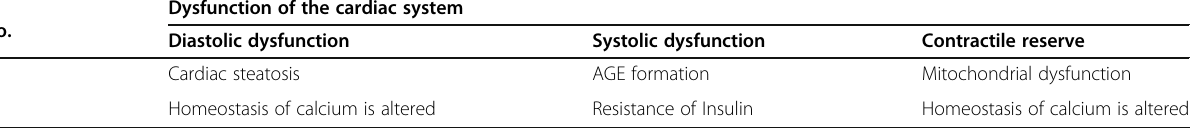
Table 3 Mechanisms contributing to diabetic dysfunction of the cardiac system S.